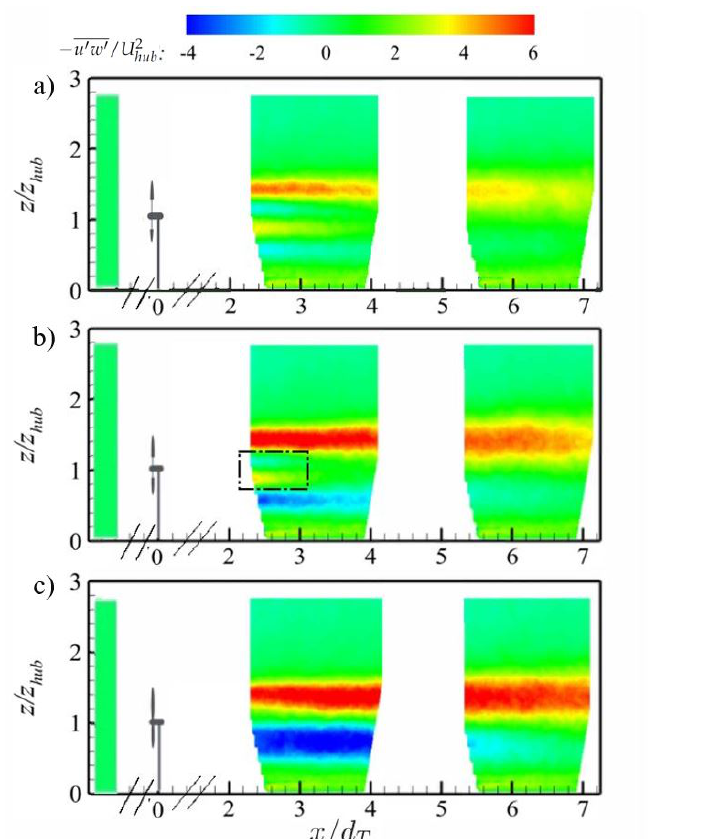
Figure 9. Kinematic shear stress − u (cid:48) w (cid:48) / U 2 ( c ) L / R = 1.